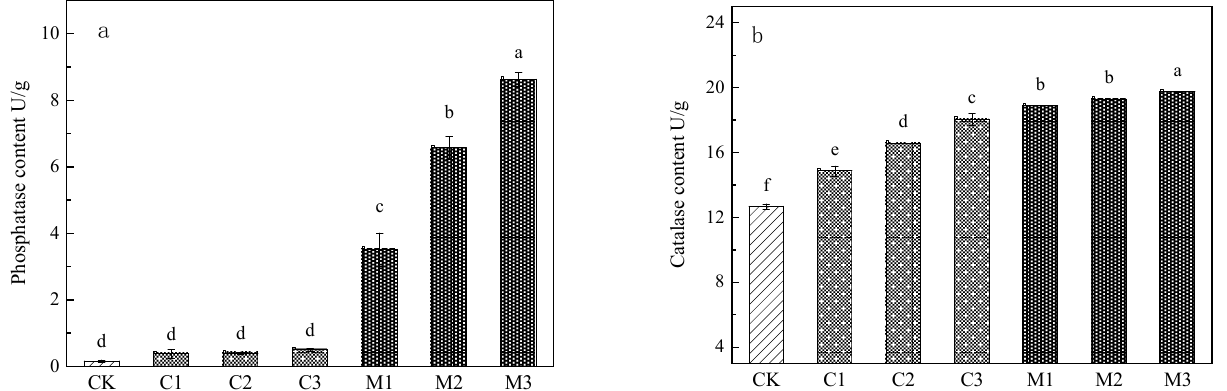
Figure 3. Enzyme activity in tailings: ( a ) phosphatase activity, ( b ) catalase